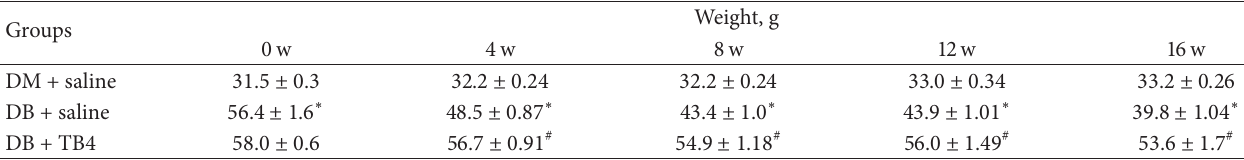
Table 2: Effect of T 𝛽 4 on body